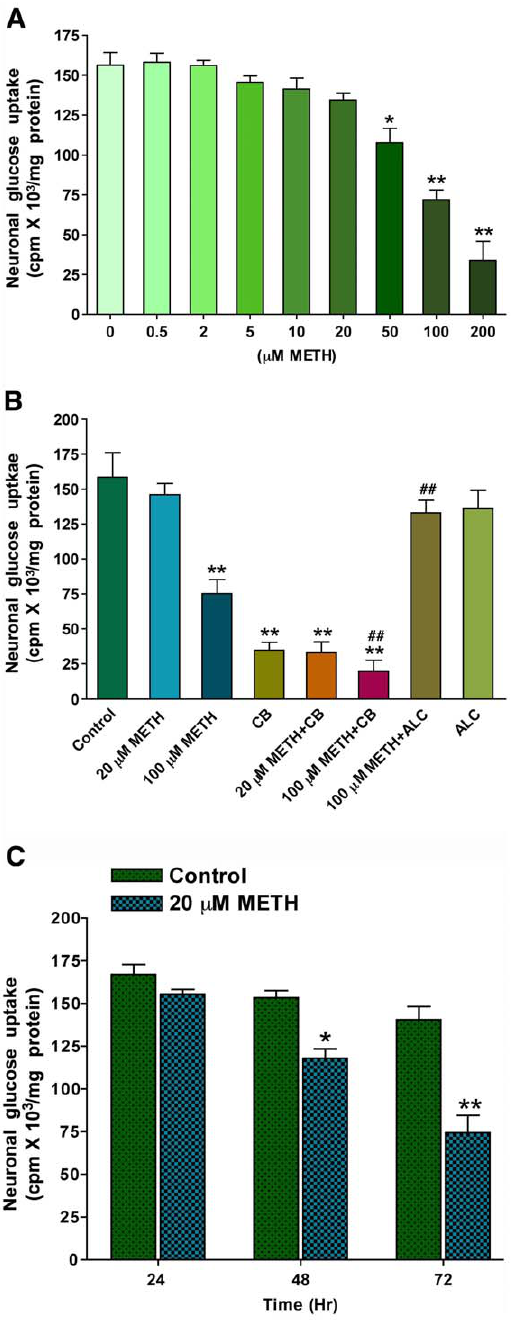
Figure 2. METH down regulates glucose uptake in human neurons: A. Dose dependent effects of METH on D-(2- 3 H)-glucose uptake by human neurons for 24 hr. B. Effects of GLUT inhibitor cytochalasin B (10 m M) and ALC (100 m M) on glucose uptake by neurons following 20 m M and 100 m M of METH for 24 hr. C. Effect of 20 m M METH on D-(2- 3 H)-glucose uptake in human neurons at 24, 48 and 72 hr exposure periods and compared with respective untreated control cells. Statistically significant, *p , 0.05, **p , 0.01 compared with controls (n=5 in A and B , n=3 in C ); ## p , 0.01 with 100 m M of METH (in B ,